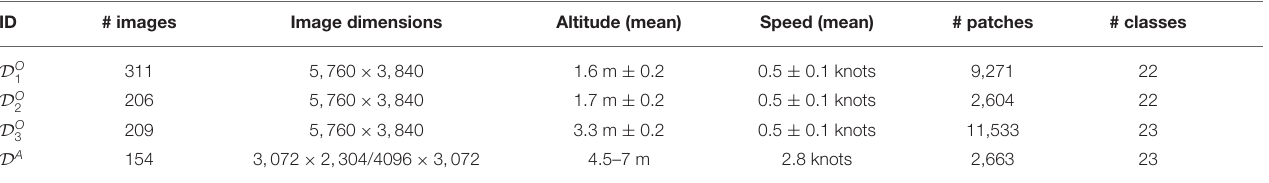
The gears were operated with different speed and altitude (both given in estimated mean value). Image patches of the 12 most abundant classes were extracted and used in our study. The total number of extracted patches from these 12 classes are given in the sixth column (see text for details). The last column shows the total number of classes found in each data set (including the ones of lesser